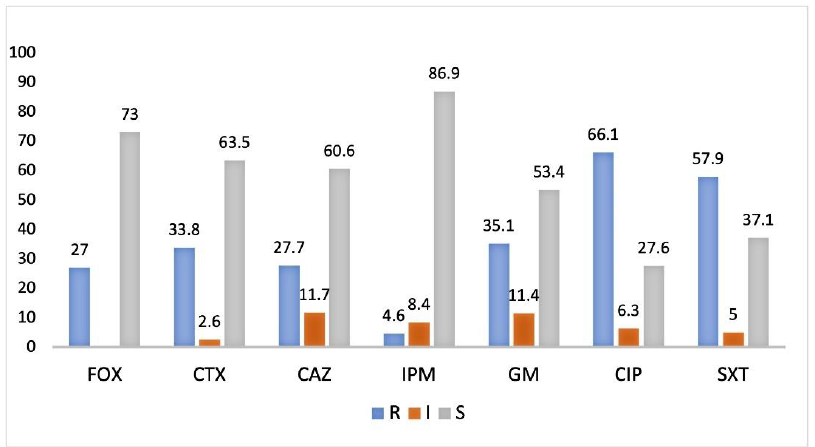
Figure 3. Antibiotic susceptibility frequency (%) of 315 isolates to cefoxitin (FOX), cefotaxime (CTX), ceftazidime (CAZ), imipenem (IPM), gentamicin (GM), ciprofloxacin (CIP), and trimethoprim-sulfamethoxazole (SXT), from influent and effluent wastewater from the Beirolas and Faro Northwest WWTPs. R-resistant; I-susceptible at increased exposure; S-susceptible at standard